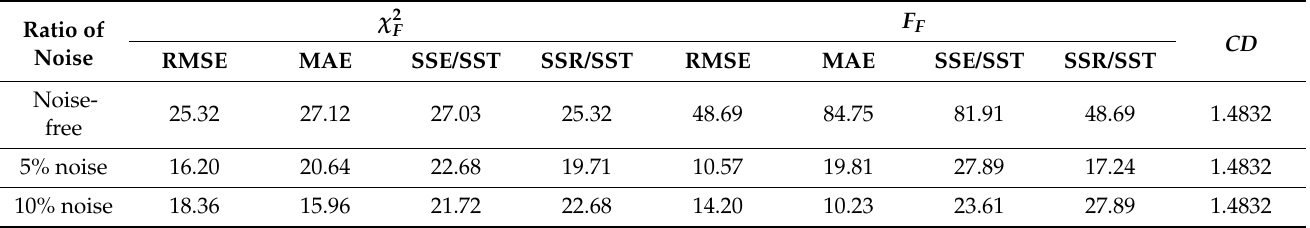
Table 10. Relevant values in the Friedman test on benchmark